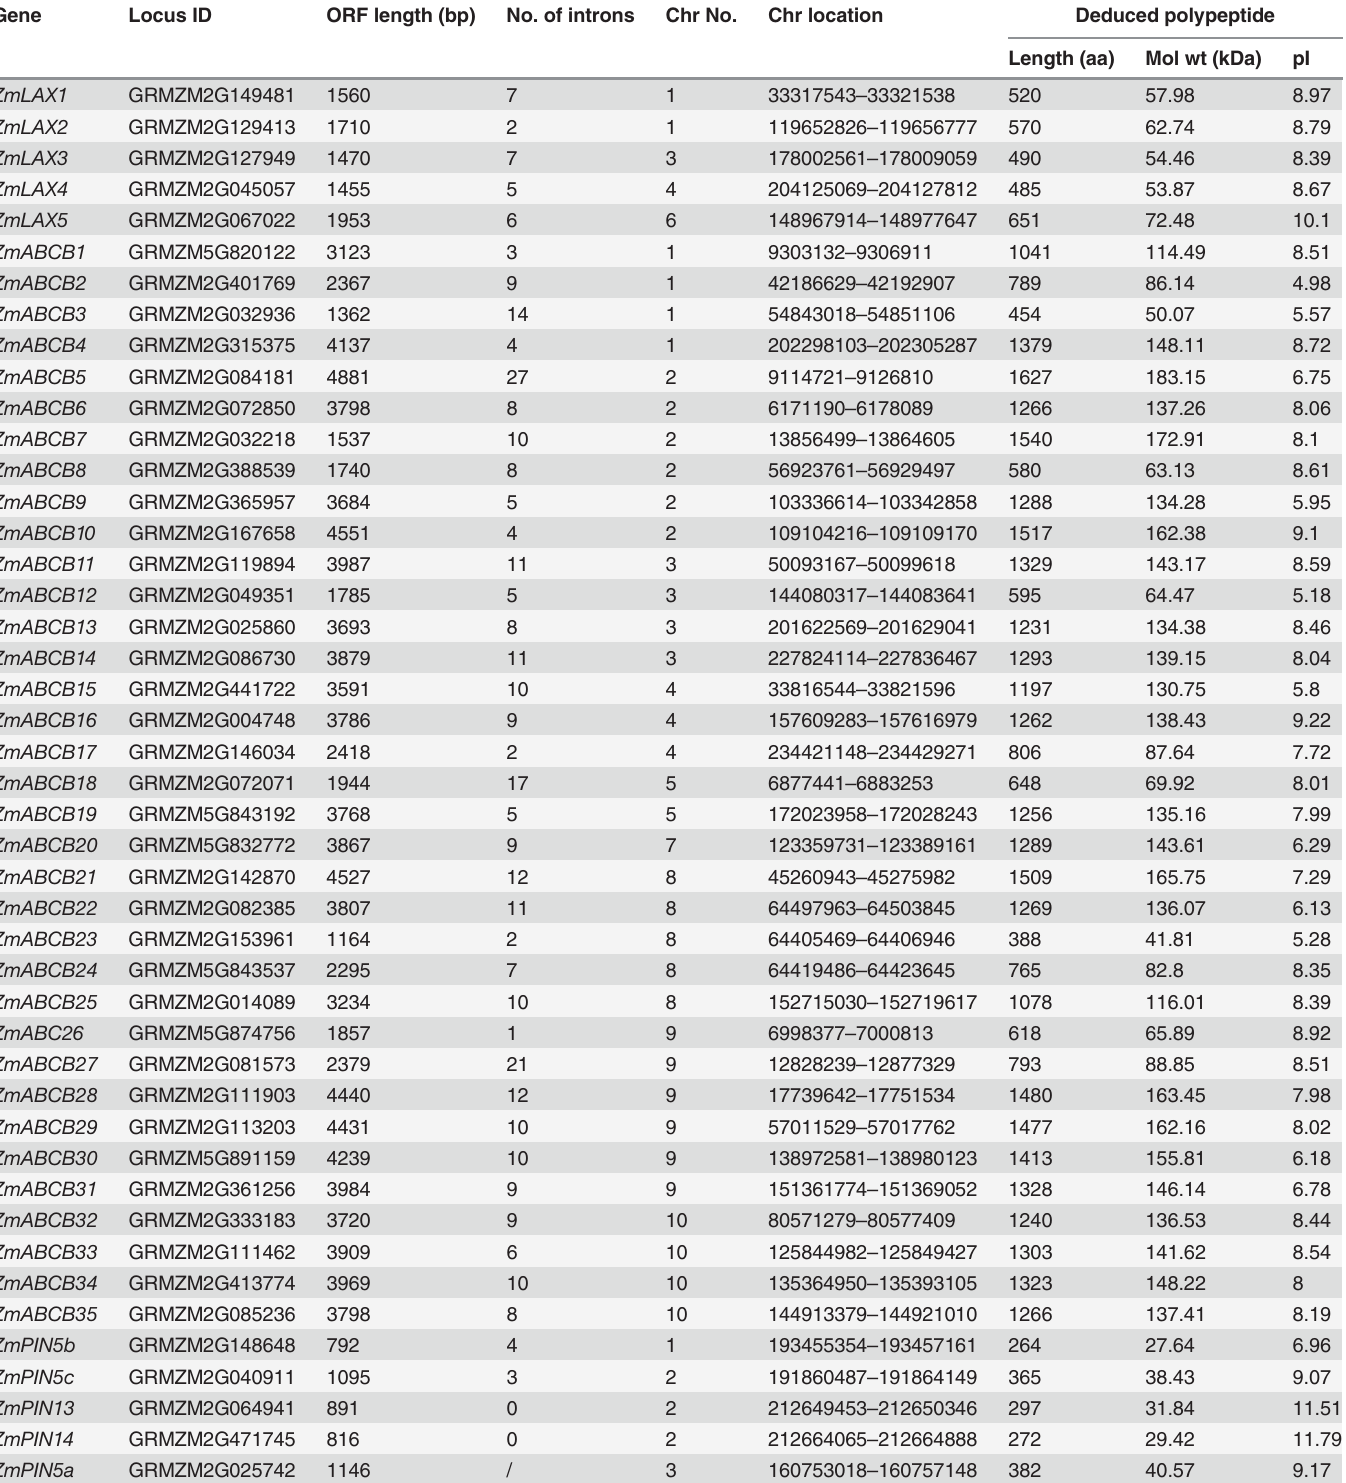
Table 1. Auxin transport genes in maize. Gene Locus